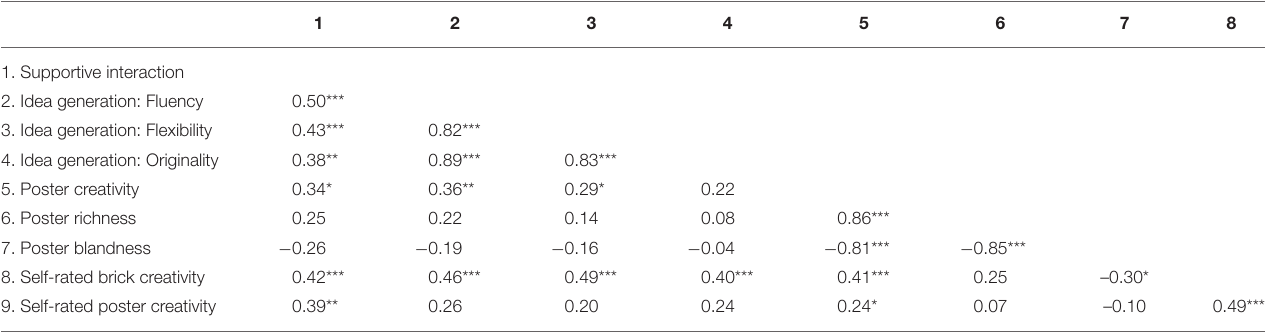
TABLE 1 | Correlations between measures of creativity and supportive interaction.